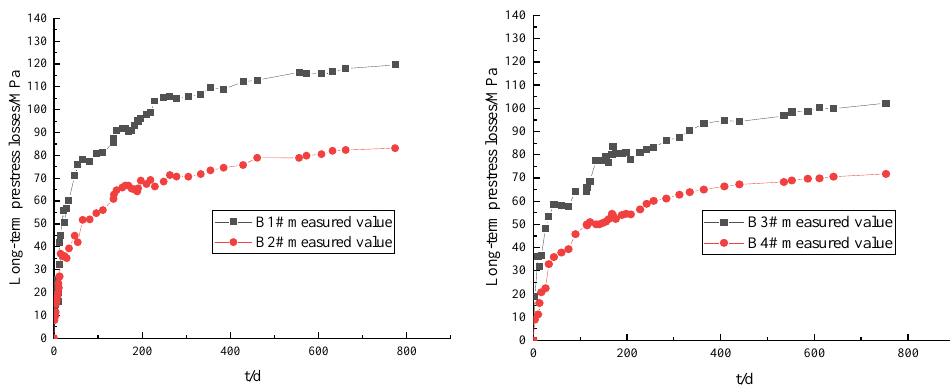
Figure 7. Comparison of long-term prestress loss values at different initial loading stress levels.